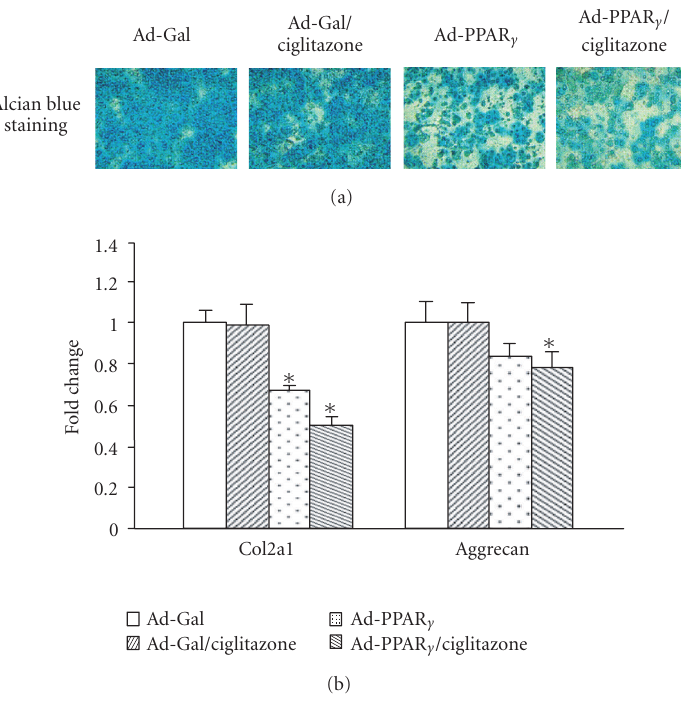
Figure 4: Loss of the chondrogenic phenotype in growth plate cells in which PPAR γ was overexpressed or cells treated with ciglitazone. (a) Growth plate cells were infected with Ad-PPAR γ or Ad-Gal followed by a 10-day incubation in the presence or absence of ciglitazone (5 μ M). Alcian blue staining shows the accumulation of chondrocyte-specific matrix. (b) Quantitative PCR analysis of chondrogenic genes, COL2A1, and aggrecan, in growth plate cells infected with Ad-PPAR γ or treated with ciglitazone at day 4 of treatment. Ad-Gal-infected cells were used as controls. Gene expression levels were normalized with respect to endogenous 18S rRNA. ∗ P < . 05 versus the expression in control